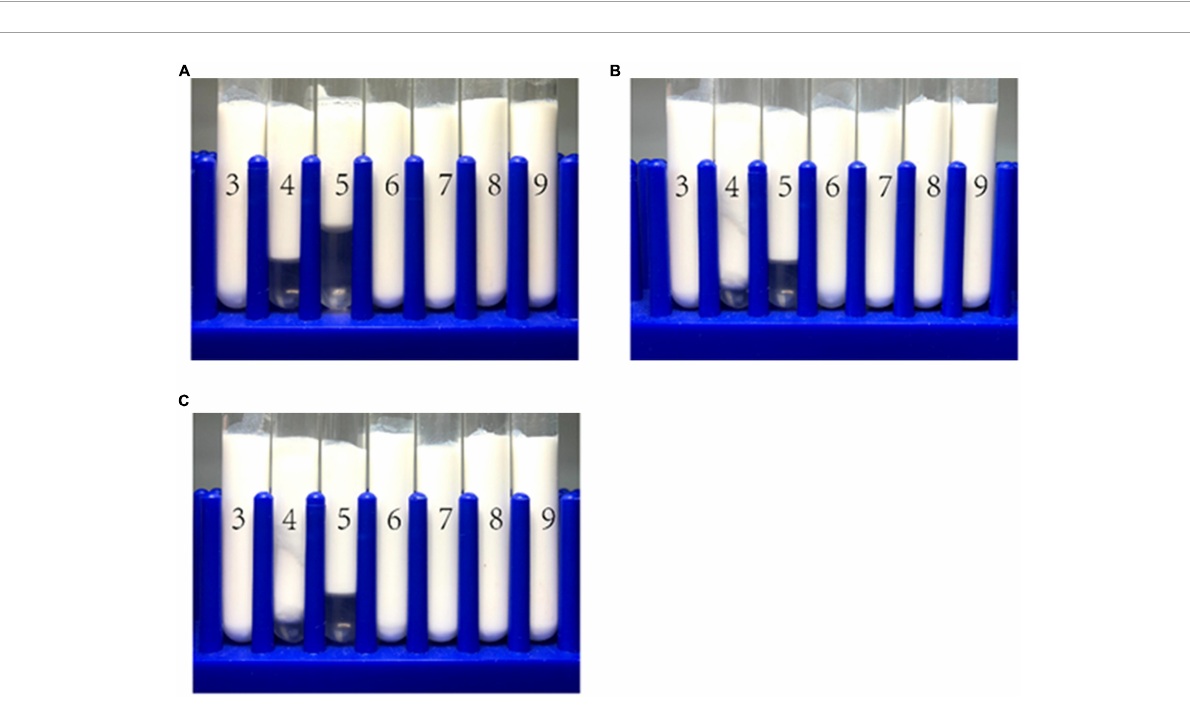
change in secondary structure in casein after interacting with tea polyphenols